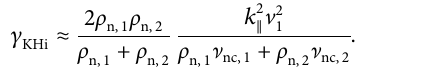
FIGURE 3 | KHi growth rate in normalized units as a function of the dimensionless ion-neutral collision frequency for a sub-Alfvénic value of the shear fl ow velocity so that Δ v < Δ v crit. . The dashed line corresponds to the incompressible case in which c KHi > 0 even for large values of the collision frequency. The other lines correspond to the compressible case for various values of the ratio of the perpendicular, k y , to the longitudinal, k z , componentsofthewavevector(indicatedwithinthe fi gure).Perturbationswith a suf fi ciently large value of the ratio k y / k z can trigger the KHi even in the compressible case. Adapted from Soler et al. (2012b). © AAS. Reproduced with